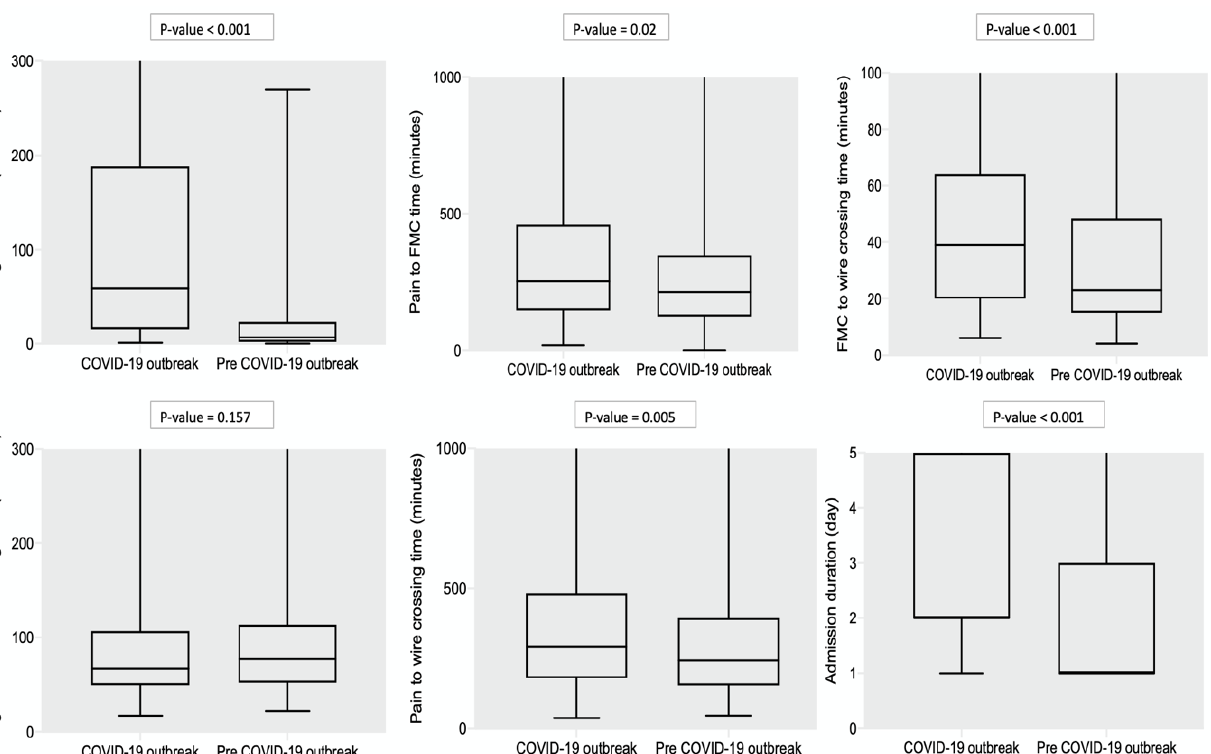
Figure 3. The box plots represent the median and interquartile range of time components for STEMI diagnosis time, pain to FMC time, FMC to wire crossing time, diagnosis to wire crossing time, pain to wire crossing time, and admission duration in pre-COVID-19 period and during the COVID-19 outbreak period.